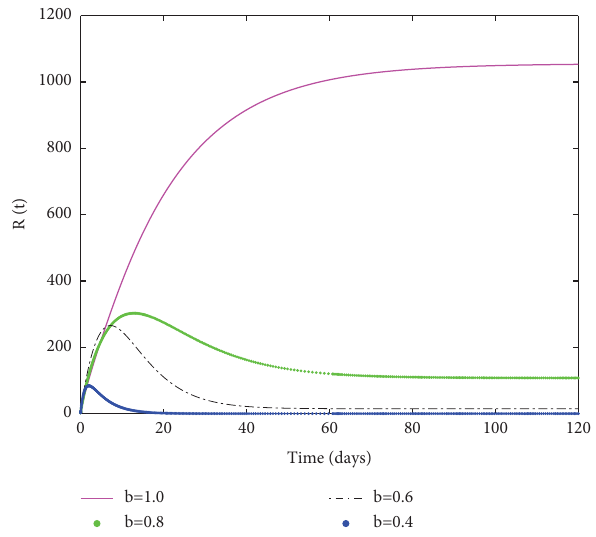
Figure 9: Behaviour of the recovered individuals at diferent values of b